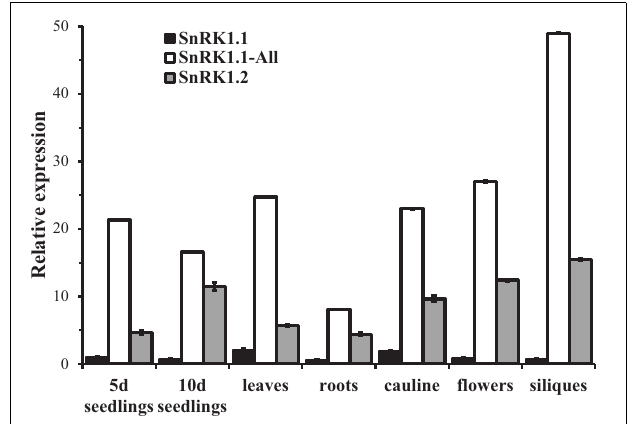
FIGURE 5 | Relative expression of SnRK1 genes as determined by real-time PCR. Primers specific for amplifying the longer cDNA clone that encodes the SnRK1.1 protein (SnRK1.1), all SnRK1.1 cDNAs (SnRK1.1—All), and SnRK1.2 were used to measure expression in 5 d and 10 d seedlings (seedlings), and tissues from 6 week-old soil-grown plants: rosette leaves, roots, cauline leaves, flowers, and green siliques. SnRK1 expression was compared to PEX4 to generate relative expression levels. Means of triplicate reactions ± SD are presented.